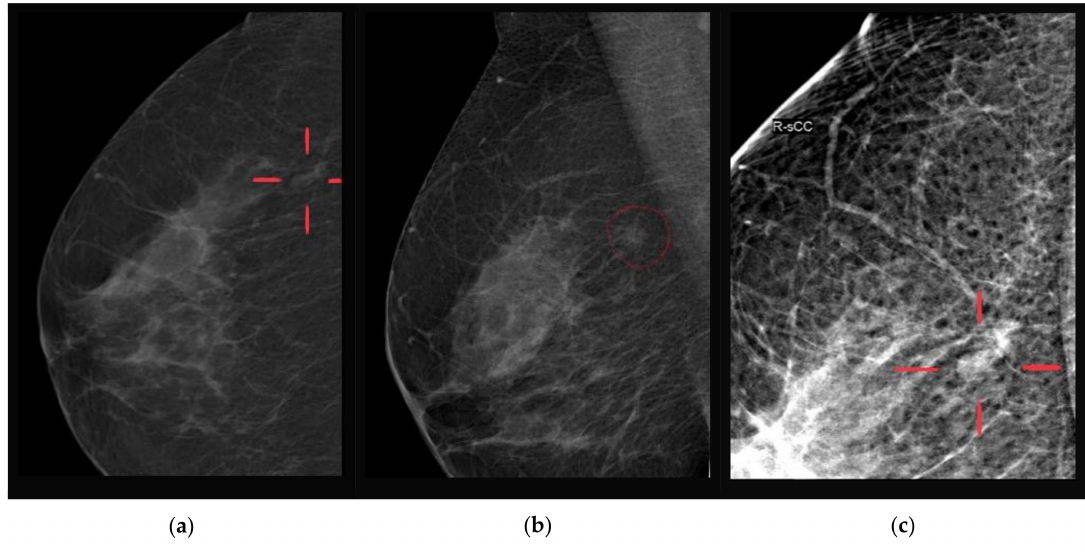
Figure 2. Screening mammograms of a 55-year-old female during insulin therapy, no breast symp- toms, negative breast cancer family history, diabetic mastopathy confirmed microscopically following core-needle biopsy: ( a ) RCC view, 6 mm asymmetrical density of the right breast, ( b ) RMLO view, 6 mm asymmetrical density of the right breast, ( c ) “spot view”, atrophy of the ducts, periductal lymphocyte